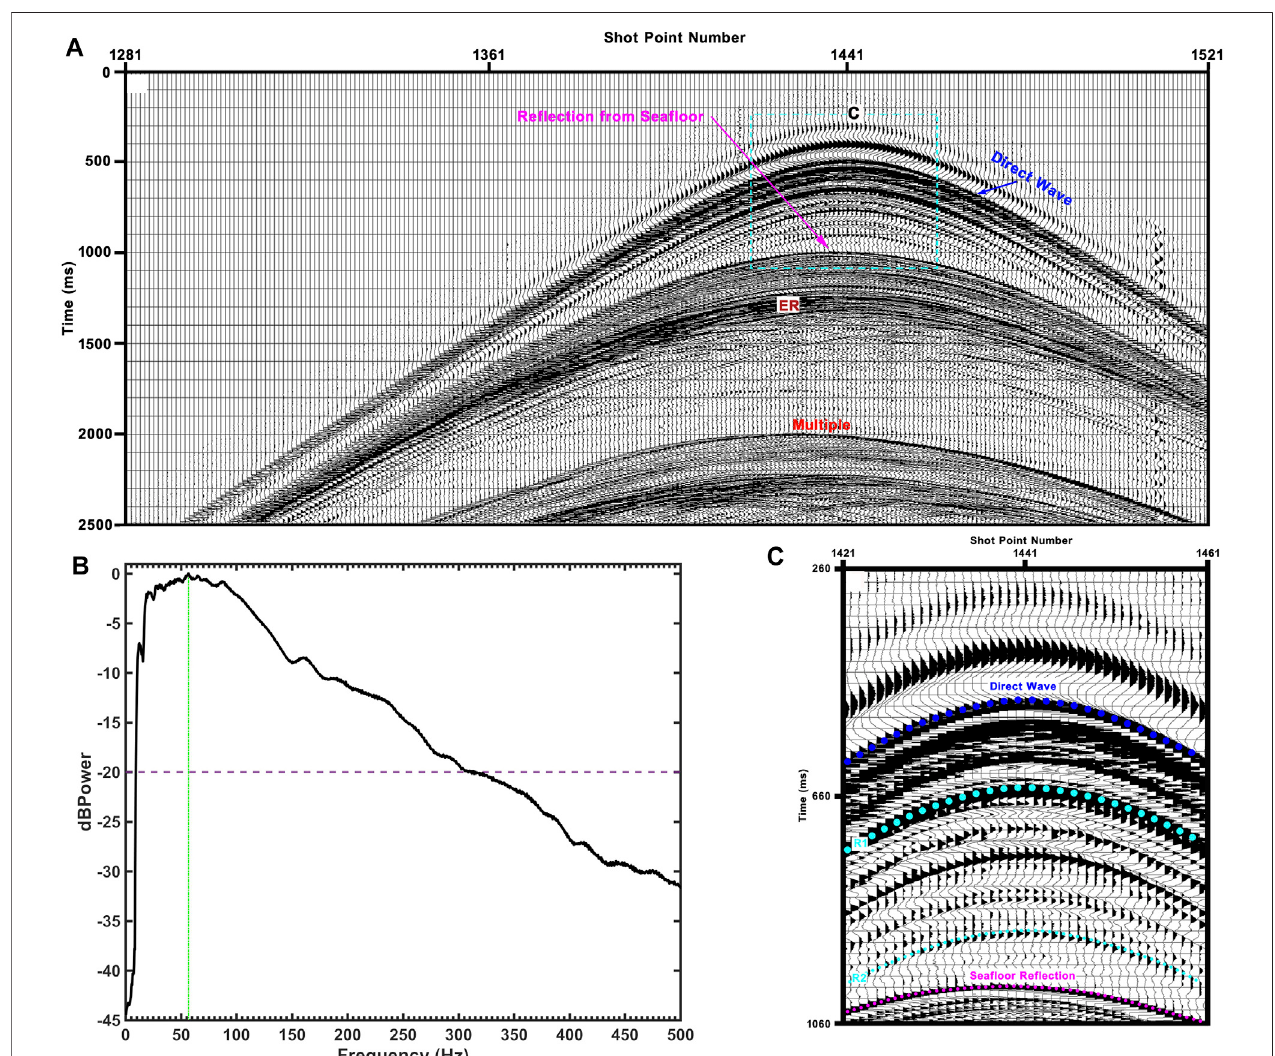
FIGURE 5 | (A) Common receiver gather from the fi rst receiver after band-pass fi ltered. (B) The spectrum of this common receiver gather. (C) The seismic re fl ections from the seawater layers. The water body re fl ections occur between dashed line R1 and R2.